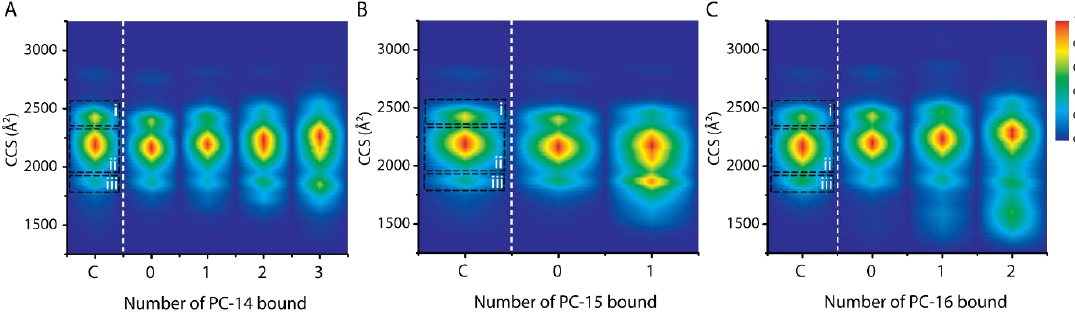
Figure 7. Comparison of fos-choline binding to α -syn. Control, without detergents present, and with PC-14, PC-15 or PC-16 at a concentration of 0.24 mM (2 × CMC PC-14, 3.4 × CMC PC-15 and 18.5 × CMC PC-16)). Dimer peaks are indicated with a ‘D’. Numbers indicate binding stoichiometries of the respective detergent.